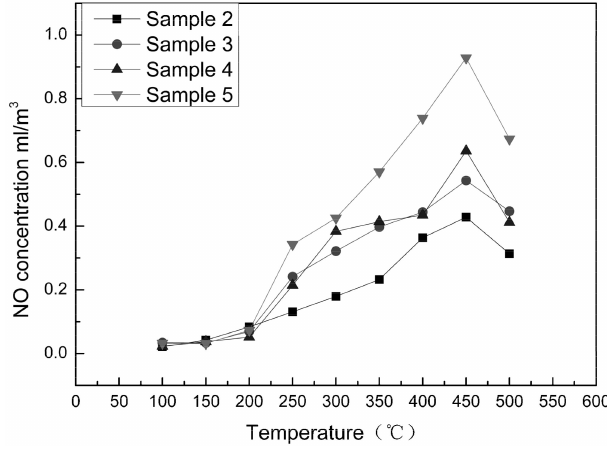
Figure 5. Activity test for di ff erent treatments of concentrate.